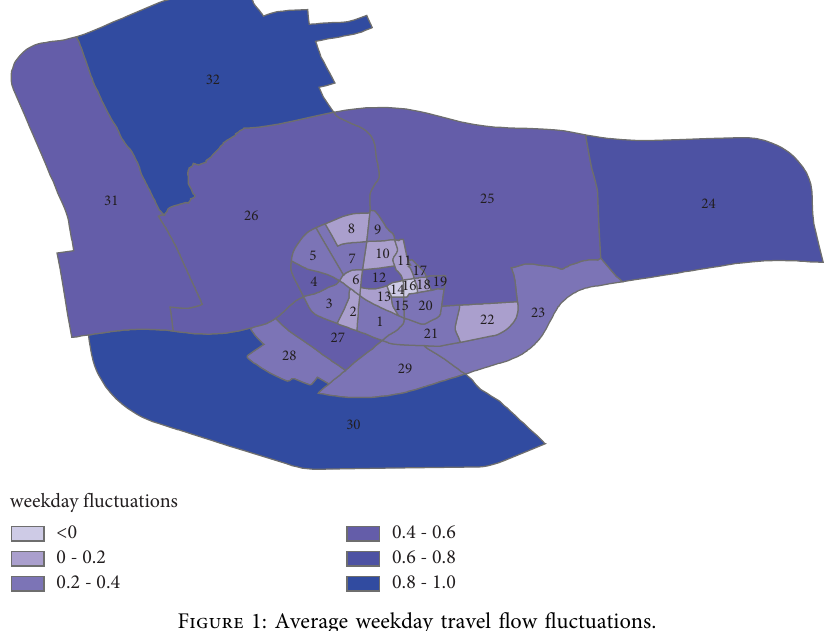
Figure 1: Average weekday travel fow fuctuations.